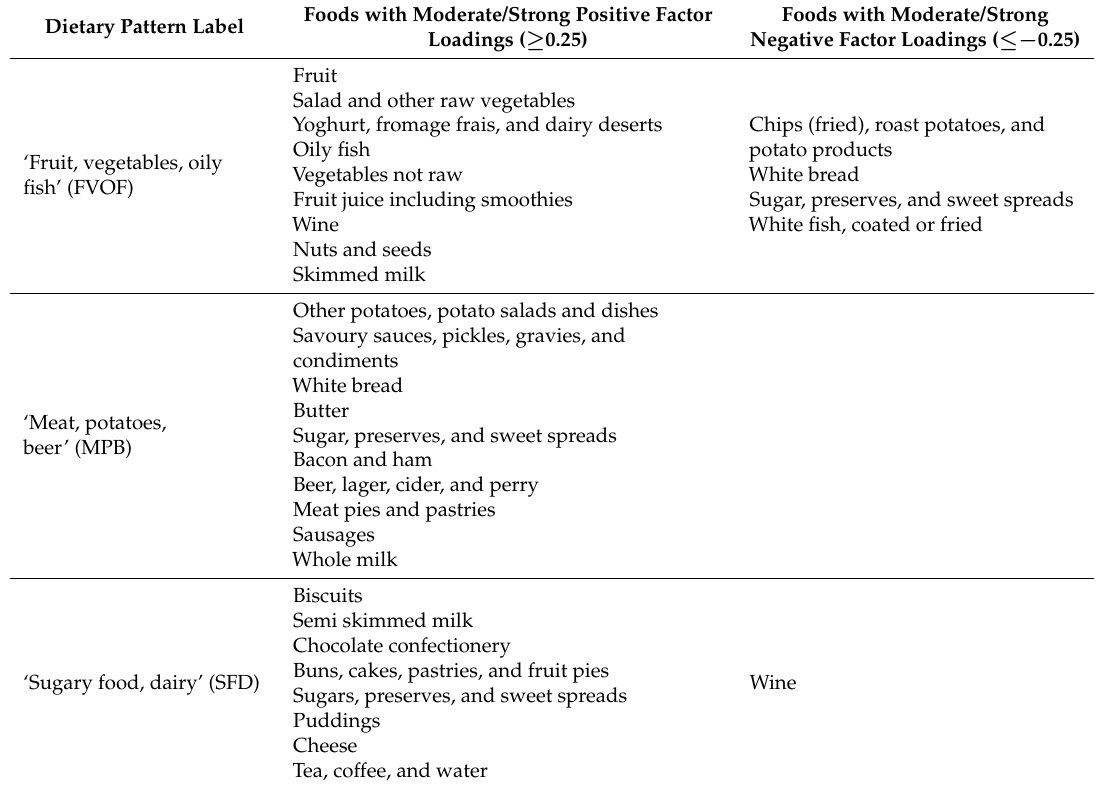
Dietary Pattern Label